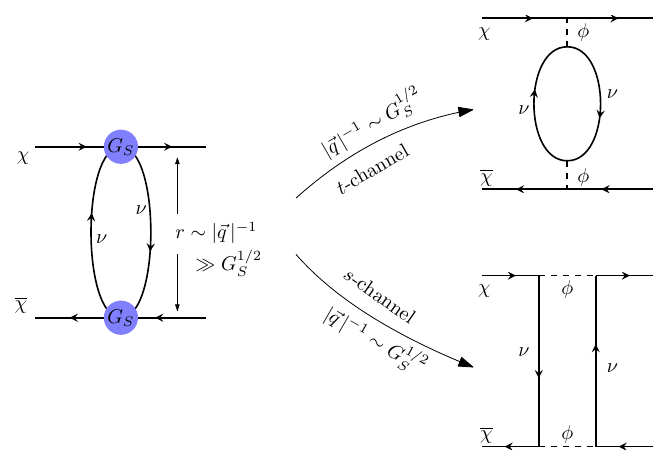
Figure 1 . Neutrino forces from neutrino-pair exchange with a contact interaction (left diagram) and possible modifications (right diagrams) when the contact interaction is invalid due to r ∼ G 1 / 2